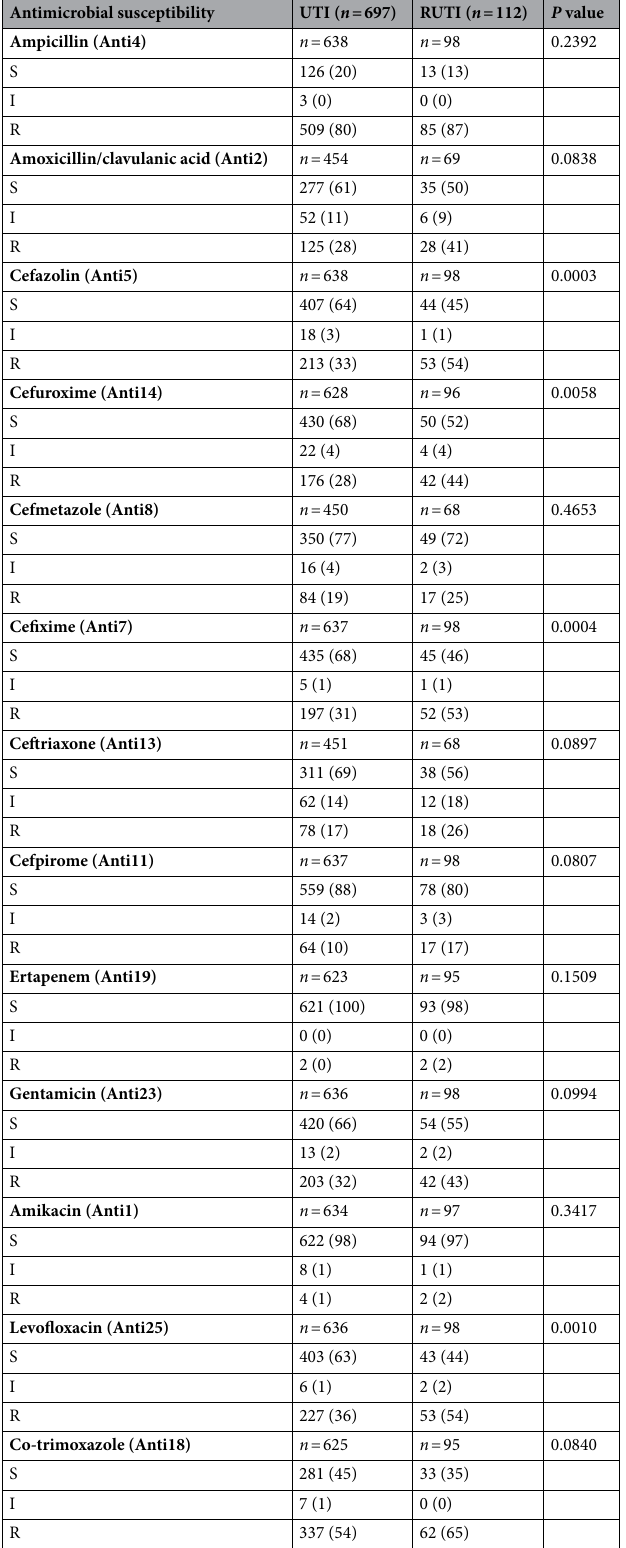
Table 3. Antimicrobial susceptibility of bacterial pathogens related to UTI and RUTI (sample size = 809) used in the second stage analysis. The name in the parentheses represents the label of the factor used in the machine learning models. Data are presented with number (percentage). Abbreviations: UTI, urinary tract infection; RUTI, recurrent urinary tract infection. S, susceptible; I, intermediate; R,